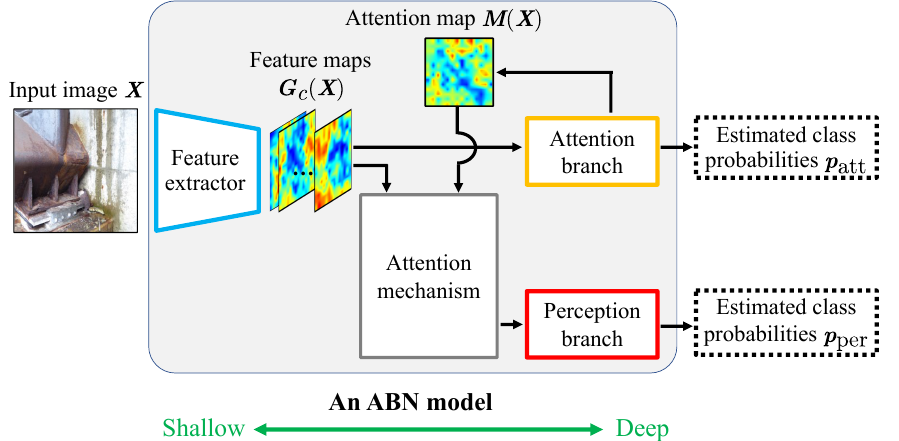
Figure 1. Overview of ABN. During the estimation, the feature extractor first outputs feature maps by using the input image. Next, the attention branch generates an attention map using the feature maps. Then the attention mechanism highlights important regions in the feature maps using the attention map. Finally, the perception branch performs the final estimation using the feature maps obtained from the attention